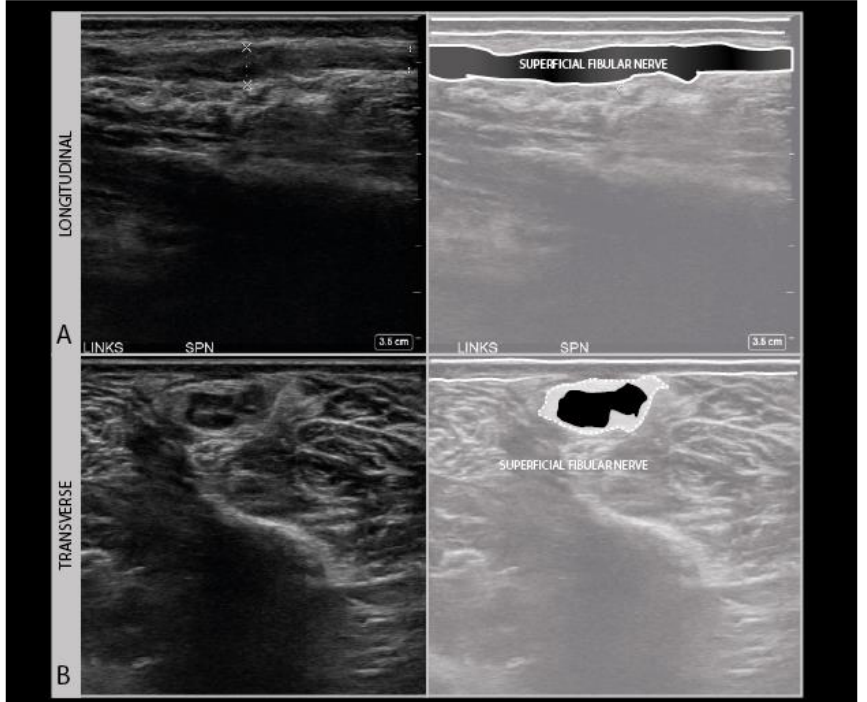
Figure 10. Disorganized and hypoechogenic superficial peroneal nerve neuroma in the distal lower leg in longitudinal ( A ) and transverse ( B ) direction; traction injury following surgical decompression with fasciotomy for anterior tibial compartment syndrome.